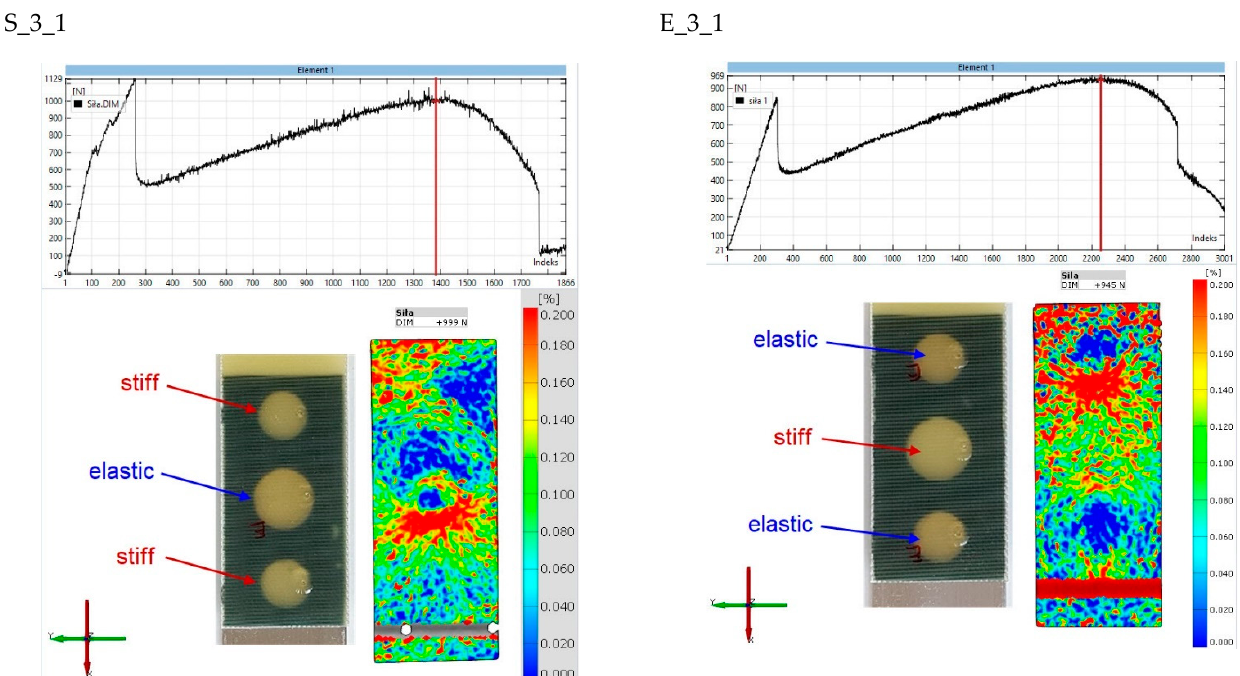
Figure 18. Comparison of principal strain maps for “S” and “E” batch 2 specimens for maximum force in the second stage of operation.